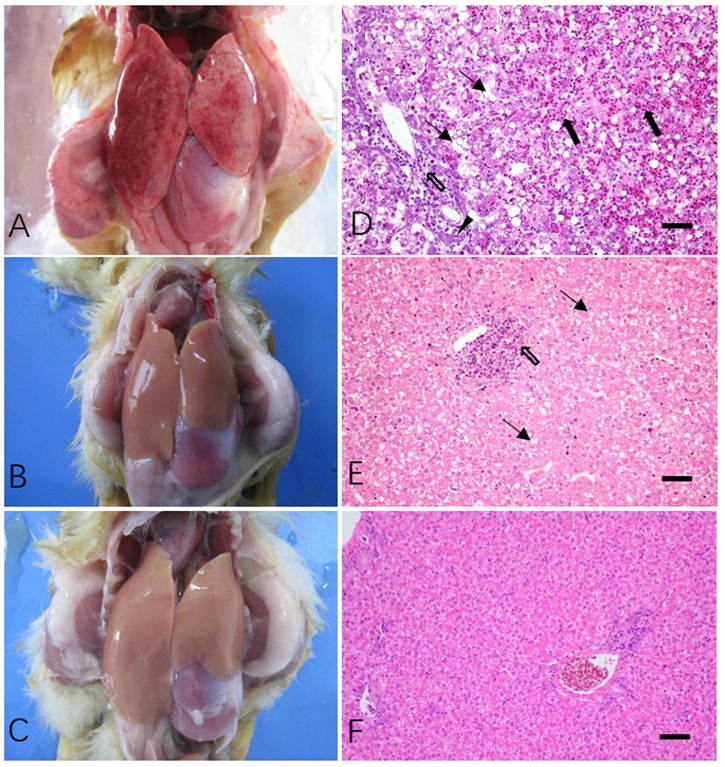
Gross and microscopic lesions of livers in Z8S2 and Z8R2 ducklings infected with DHAV-3 at 30 hpi. (A) Redness and numerous hemorrhagic spots in livers from dead ducklings of Z8S2 and Z8R2 flocks. (B) No significant cross lesions in livers from live ducklings of Z8S2 and Z8R2 flocks. (C) A liver from mock-infected ducklings. (D) Hepatocyte necrosis (arrow), hemorrhage, congestion (black arrow), bile duct hyperplasia (triangle) and significant inflammatory cell infiltration (hollow arrow) in dead ducklings of both Z8S2 and Z8R2 flocks. (E) Slight vacuolar degeneration (arrow) and focal lymphocytic aggregations (hollow arrow) in live ducklings of both Z8S2 and Z8R2 flocks. (F) No gross and microscopic lesions in livers of mock-infected ducklings. Bar = 50 μm.